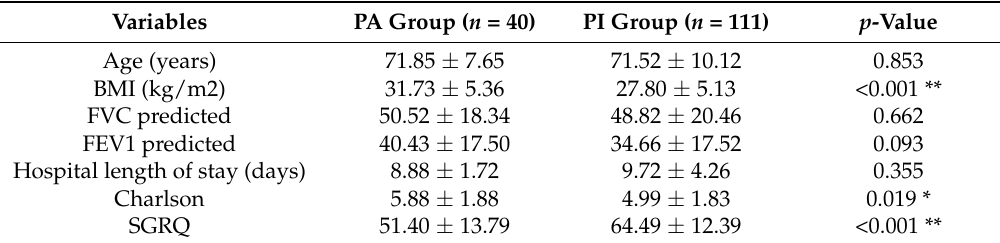
Table 1. Characteristics of patients at baseline.